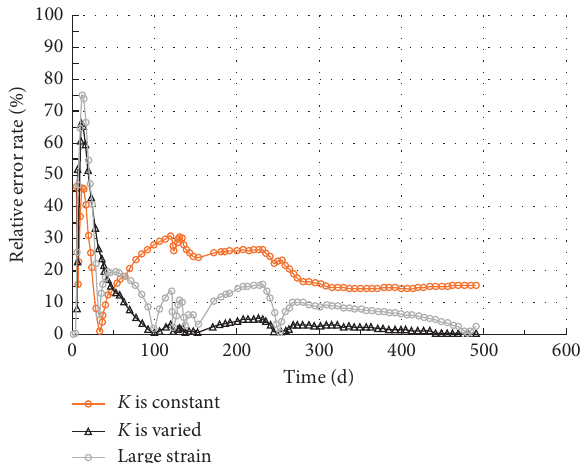
Figure 7: Relative error rate between the numerical calculation results and the settlement monitoring value.